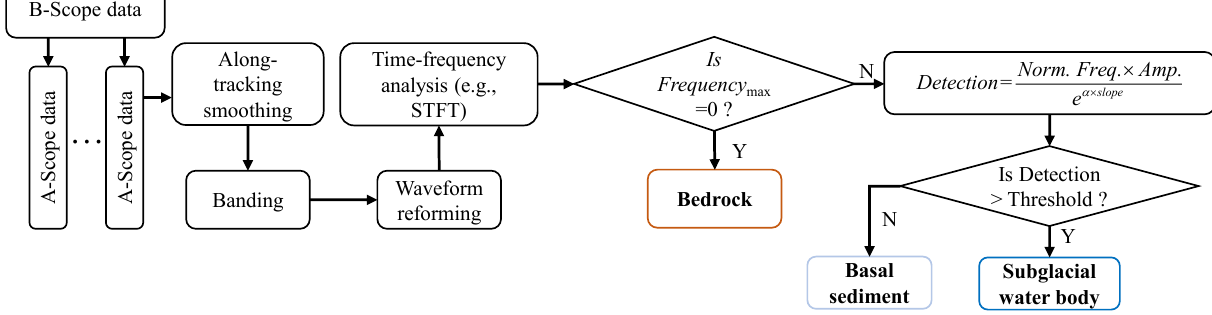
Figure 3. Flowchart of the proposed method.